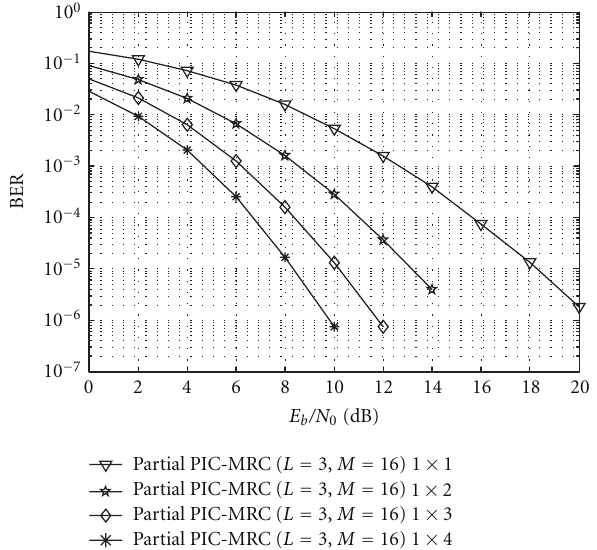
Figure 14: BER performance of partial PIC-MRC SIMO systems.